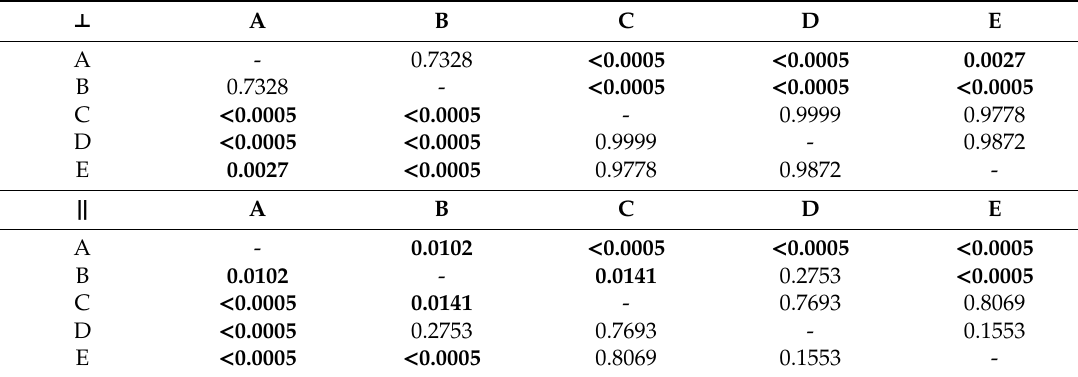
Table 4. Tukey’s honest significant di ff erence (HSD) test, p -values.